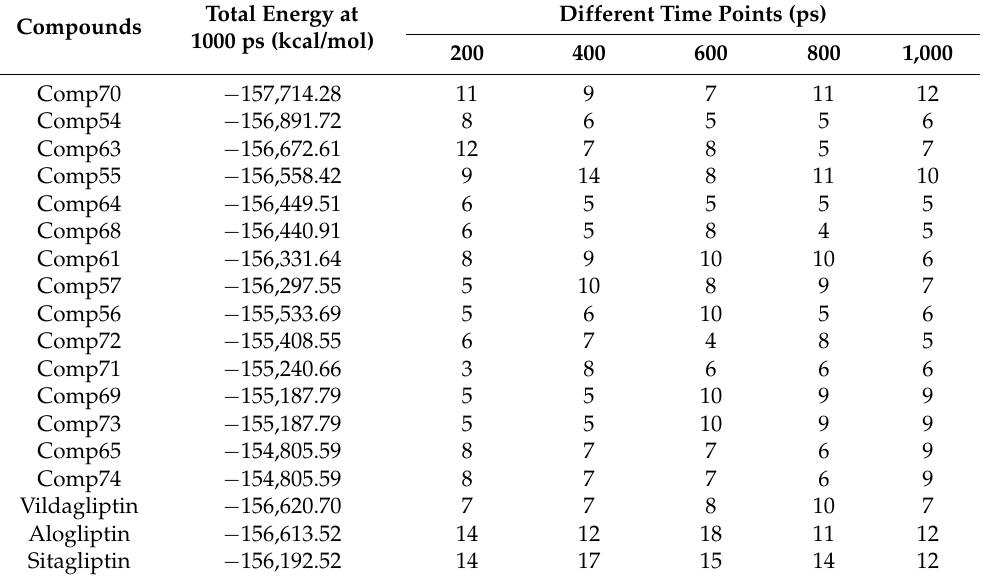
Table 3. The total energy at 1000 ps and number of intermolecular H-bonds for each compound at different time